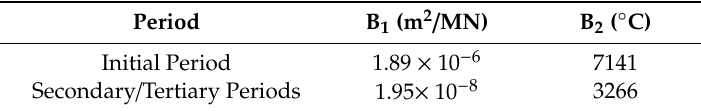
Table 3. Calibrated constants of the wear rate